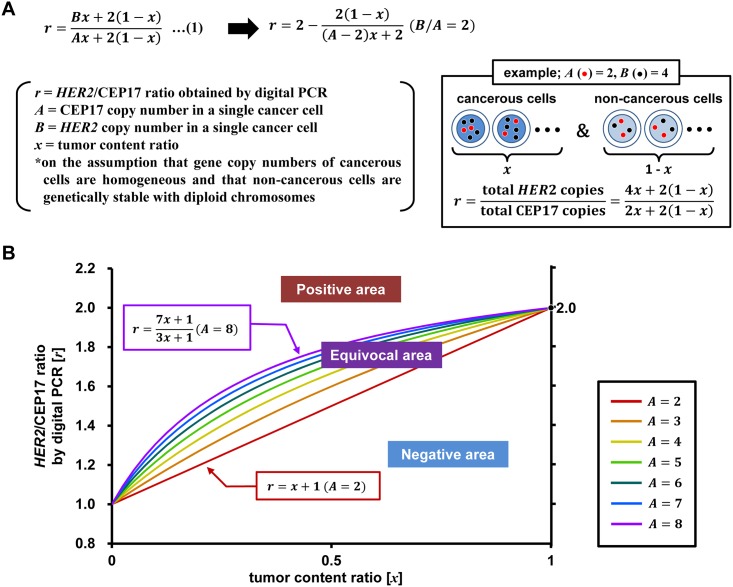
Equations and TC chart.(A) Mathematical representation of the correlation between HER2/CEP17 ratios obtained by digital PCR [r] and TCR [x] (upper). When [B/A = 2], [r] is represented by the right side of the equation (indicated by an arrow), and the right-hand member of the equation indicates a monotonic increase. A schematic model is shown for [A = 2] and [B = 4] (lower right). (B) TC chart demonstrated by Eq (1). The relationship can be plotted as a straight line (red) represented by [r = x + 1], which is the threshold between negative and equivocal areas. As the value of [A] exceeds 2.0, lines become increasingly convex and curve upwards according to this equation. Lines converge at the coordinates (0,1) and (1,2). In clinical samples, [A] was limited to a value between 2 and 8. The area enclosed by the straight red line [r = x + 1](A = 2) and the purple line curving upwards [r = (7x + 1)/(3x + 1)](A = 8) was designated as the equivocal area, and the area above the purple line was designated as the positive area.